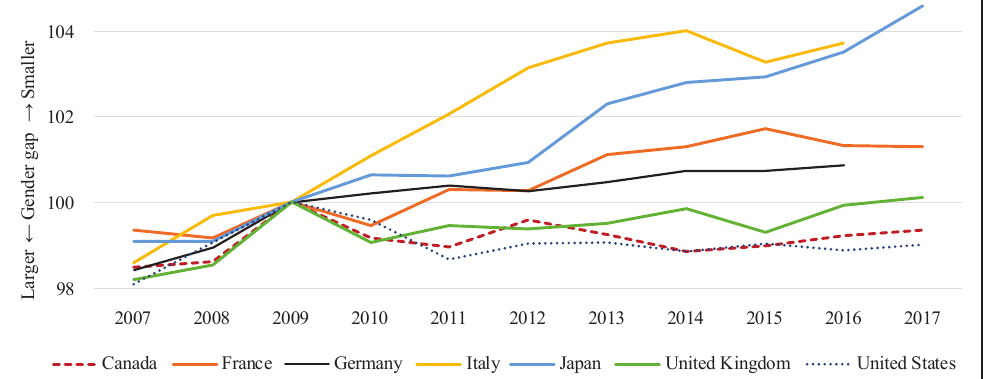
Female share of total employment: